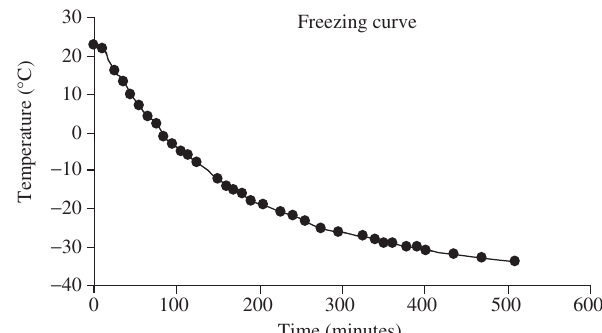
Figure 7. Freezing curve specimens submitted at low temperatures. Source: Lima 9